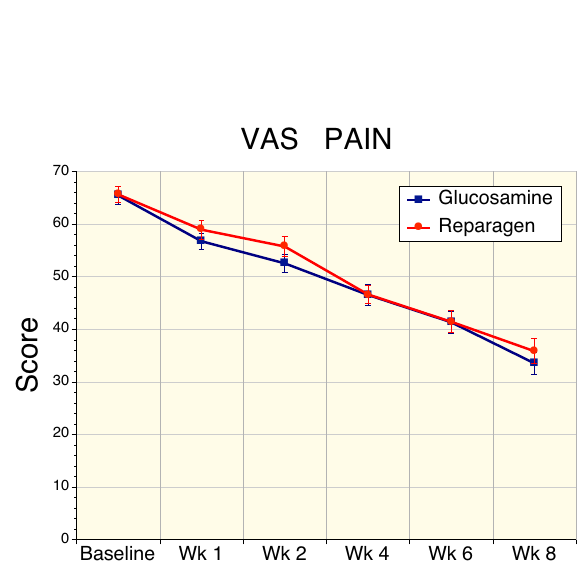
Sequential changes in WOMAC function scores for repara-gen (red, n = 48) and glucosamine sulfate (blue, n = 47). Both treatments resulted in a significant improvement in function within one week (reparagen p < 0.01, glucosamine p < 0.05) with continued improvements with sustained administration (p < 0.001).